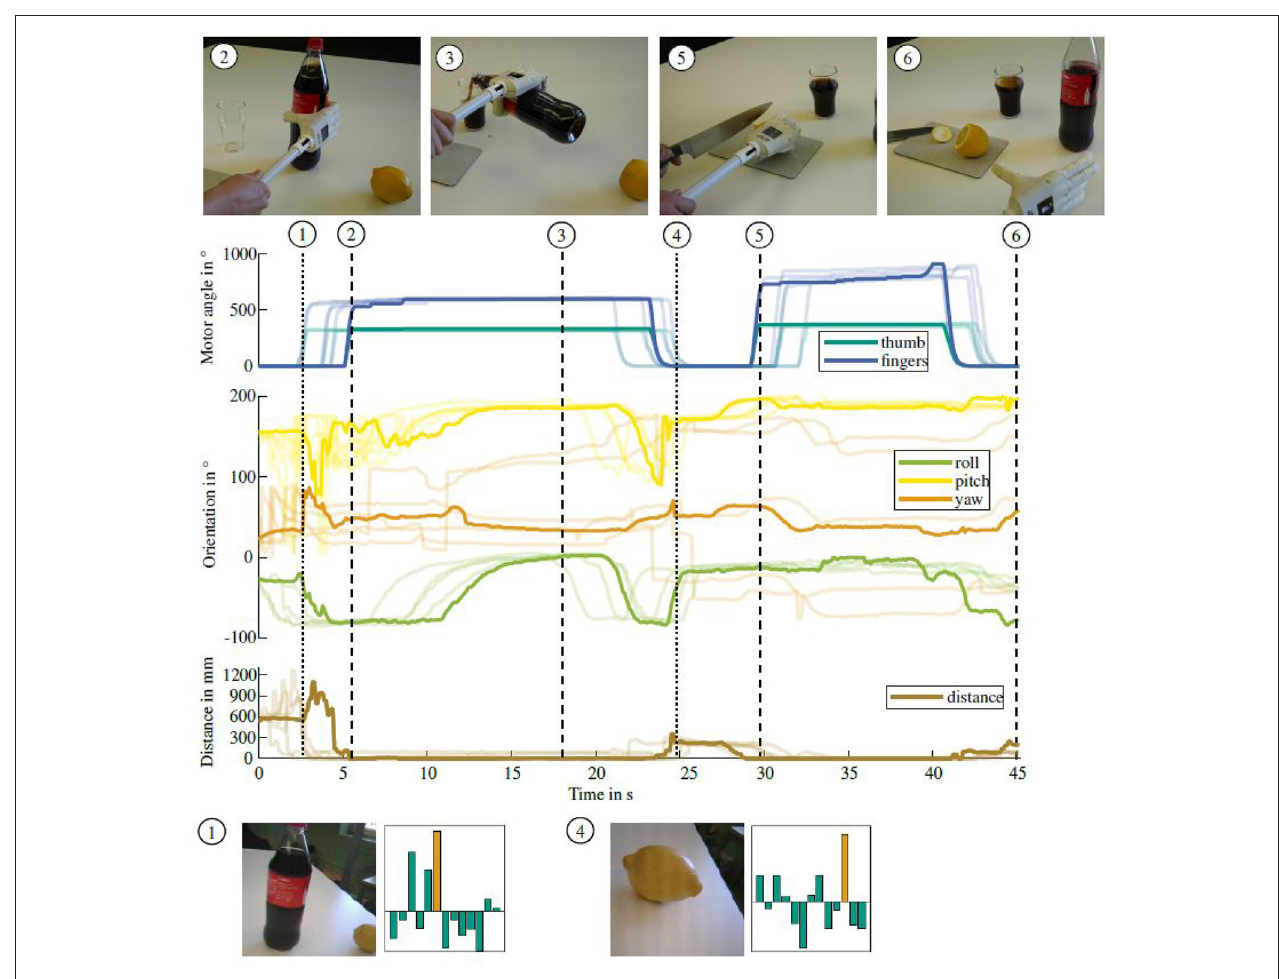
FIGURE 9 | Sensor readings while pouring coke into a glass and adding a slice cut off from a lemon. Graphs show an exemplary measurement of the motor positions, hand orientation from the IMU and object distance. Four additional experiments printed in the background underline the reliability of the sensor data. Important events of the grasping process are marked by dashed lines and corresponding images of the scene are shown above the graphs. The triggering of the object recognition is marked by dotted lines and an images captured by the hand camera together with the object recognition probabilities are shown below the graphs. The recognition probability of the coke bottle and lemon, respectively are marked in orange in the bar chart, indicating the object was recognized